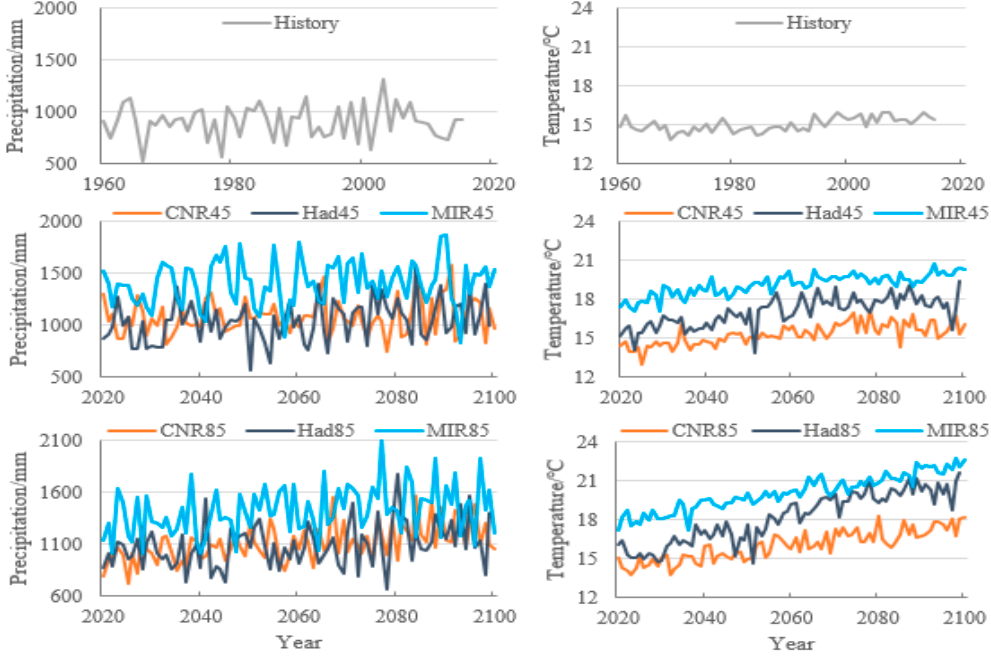
Figure 3. Changes of annual precipitation and temperature historically based on ground observed data and in the future based on the projected data under RCP4.5 (45) and RCP8.5 (85) scenarios. Table 3. The mean value of annual and seasonal precipitation ( P / mm) and Mann-Kendall test values ( Z ) historically (1960–2015) and in the future